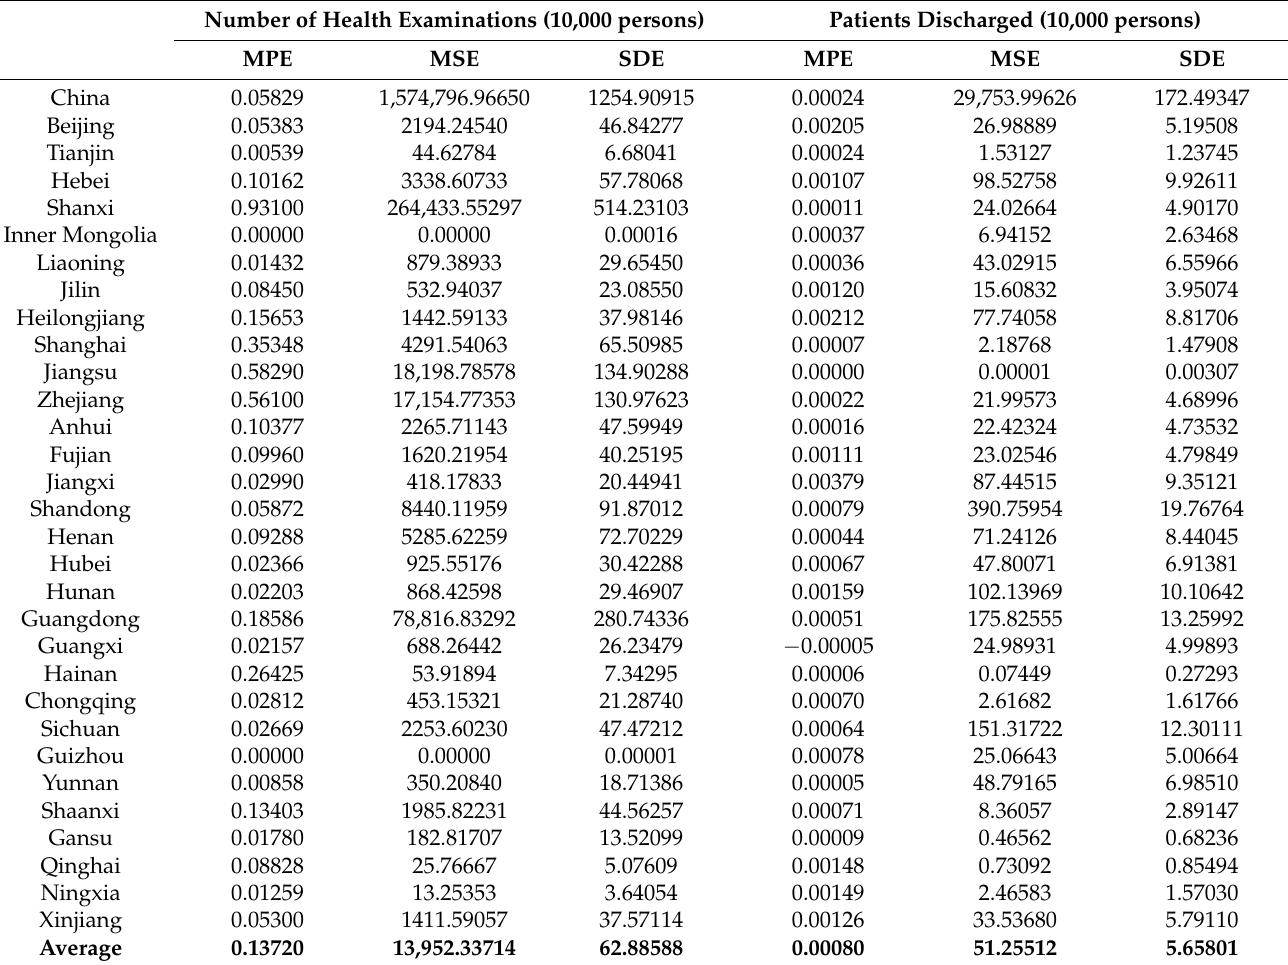
Table 6. The Second Part of Forecasting performance of LS-SVM-FM